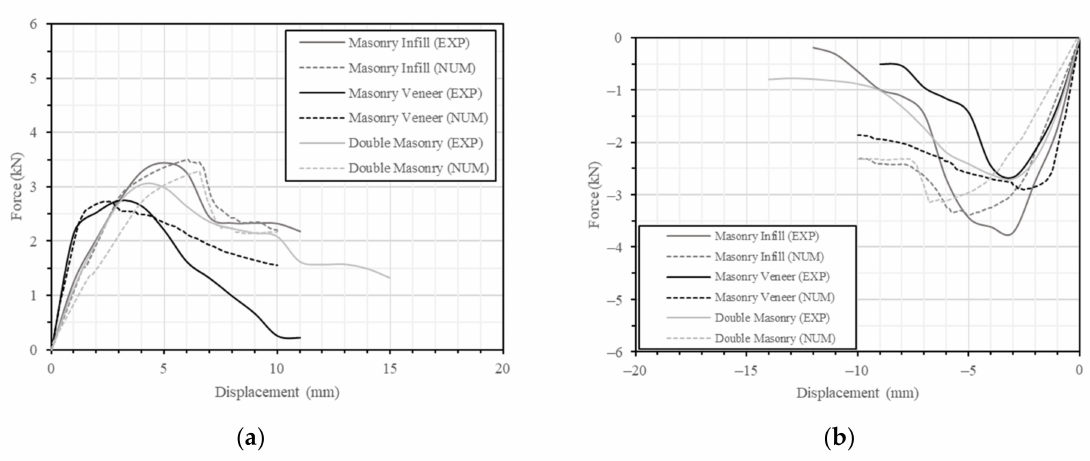
Figure 9. Numerical and experimental load–displacement curves obtained in: ( a ) tension; ( b ) compression.